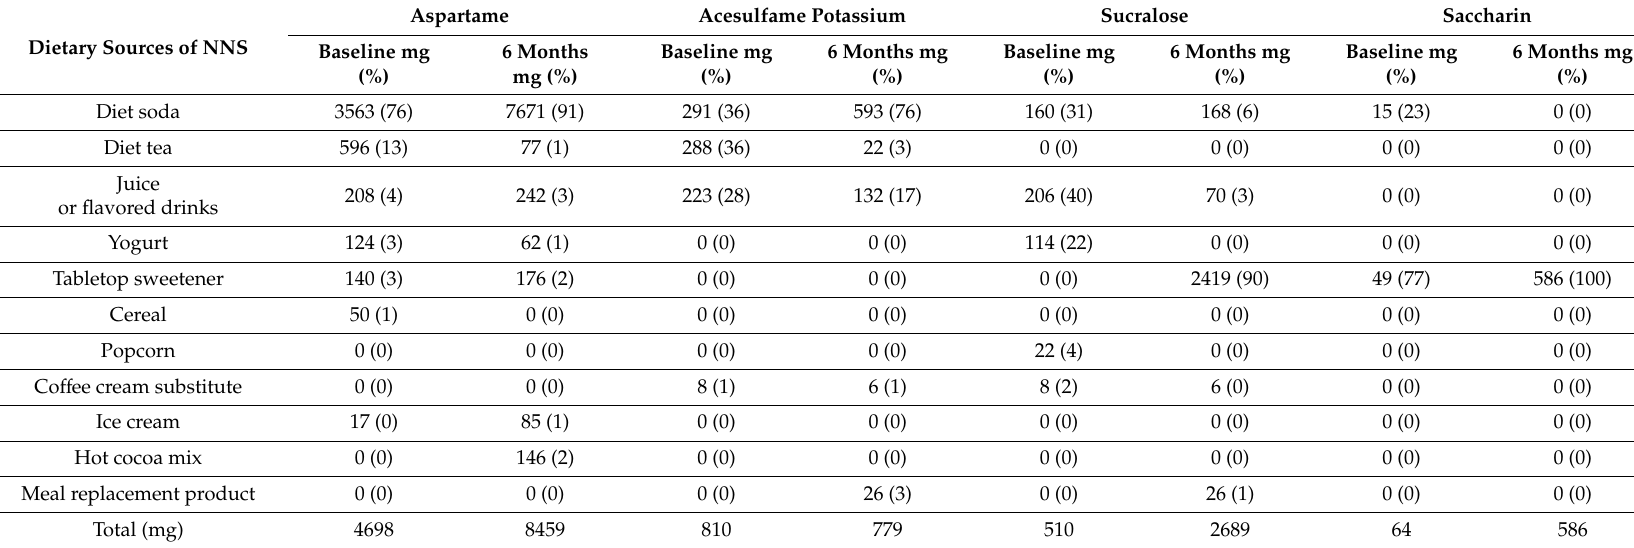
Table 3. Changes in the contribution of dietary sources to specific total daily non-nutritive sweetener (NNS) intake among SIPsmartER NNS consumers at baseline ( n = 30) and 6 months ( n = 46) a